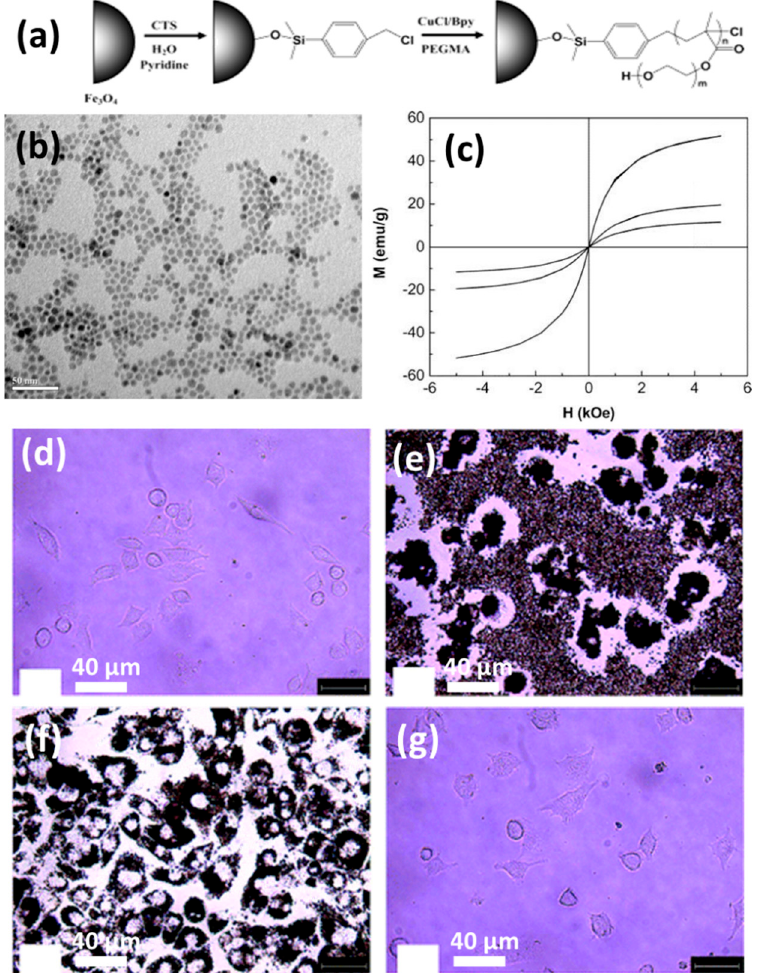
Figure 6. ( a ) Reaction scheme of the PEGylation of MNPs. ( b ) TEM image of MNPs. ( c ) Saturation magnetization plot for pristine and surface-decorated MNPs. ( d ) Monocyte/macrophage-like cells (RAW 264.7) in a control experiment. Cells after culturing in a medium containing pristine magnetic nanoparticles for ( e ) 1 day and ( f ) 4 days. ( g ) Modified MNPs in cultured media [112] © 2021 American Chemical